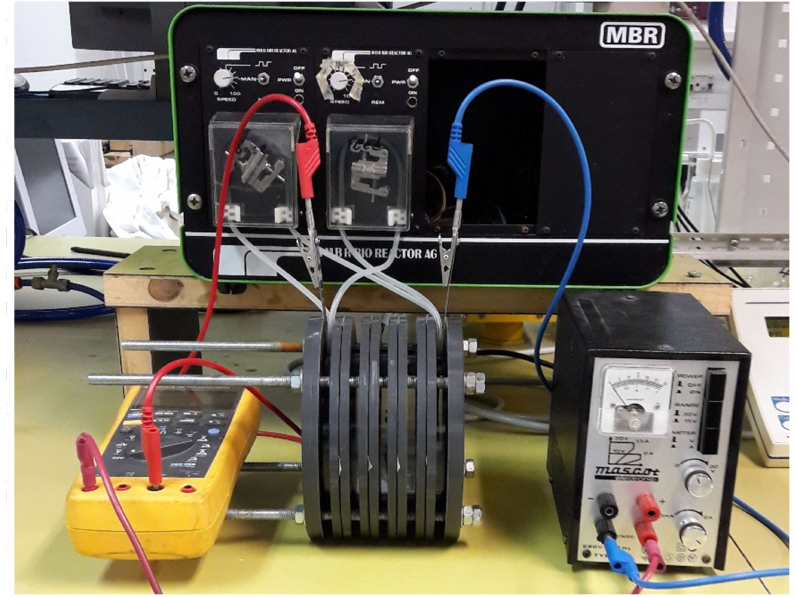
Figure 4. Experimental setup for a five compartment stack with 18 mm cells showing the power supply (right), electrodialysis stack (middle) and the multimeter for measuring the electric current through the stack (left). Pumps for recirculation are also visible (above/behind the